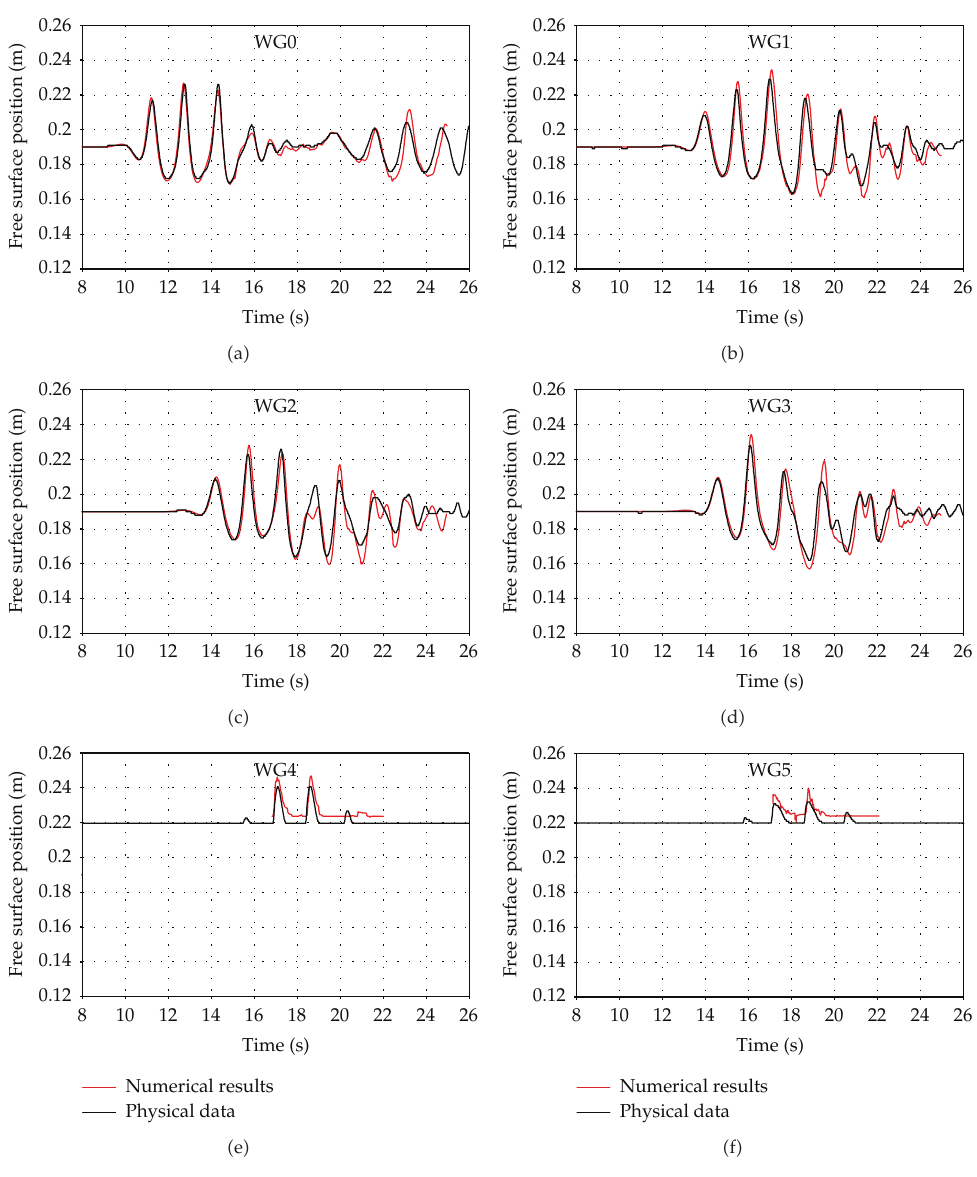
WG4 which is smaller than 0.005 m. This value is below the numerical resolution in this zone as well as being close to the minimum free surface physical sensor accuracy. For the two main overtopping events, the numerical flume reproduces quite well the free surface evolution at both free surface sensors located over the structure (cid:2) WG4 and WG5 (cid:3) . The reduction from WG4 to WG5 of the maximum water level reached by the water flow is also well